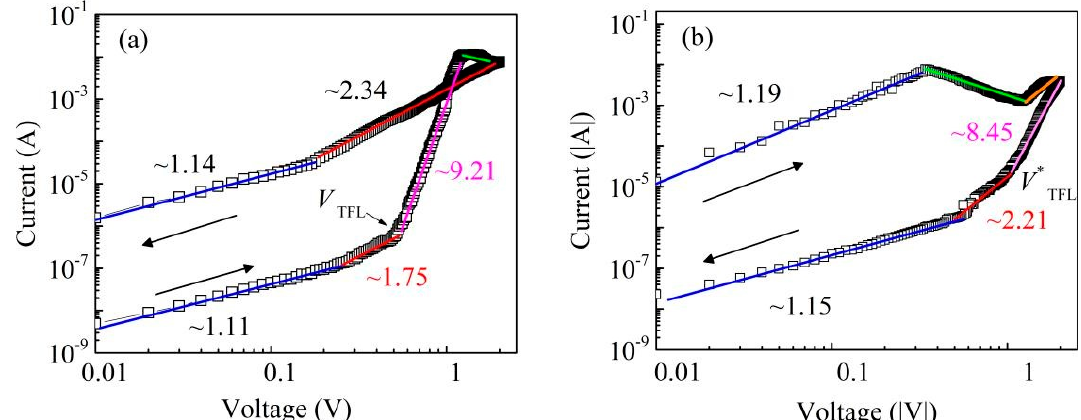
Figure 4. Log-log plot of I – V for ( a ) the positive bias region (0~2 V) and ( b ) the negative bias region (0 to − 2 V) under light illumination.